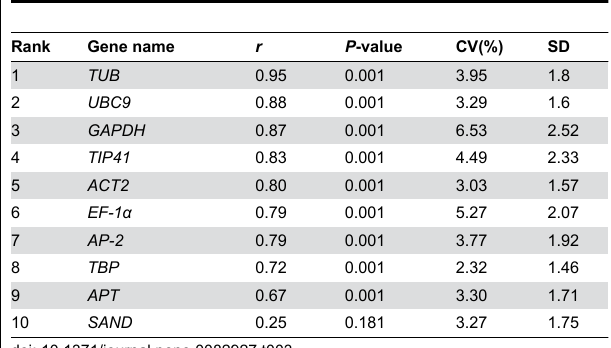
Table 3. Statistics results by BestKeeper program for ten selected genes based on Ct